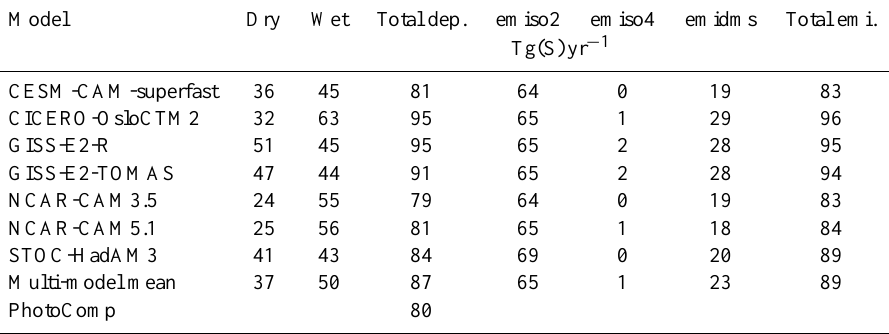
Table 4. Summary of global totals (Tg(S)yr − 1 ) for year 2000 of deposition and emissions related to the sulfur emissions. “Total dep.” (4th column) is the sum of wet and dry deposition (both sums of SO 2 and SO 2 − ), while “Total emi.” (8th column) is the sum of SO 2 , SO 2 − and 4 4 DMS emissions. Note that the deposition total should be smaller than the emission total since the formation of sulfate from the oxidation of DMS has a yield smaller than 1; this was estimated to be 87% in Boucher et al. (2003) when both gas-phase and aqueous-phase reactions are taken into account. All numbers are rounded to the nearest integer. Model Dry Wet Total dep. emiso2 emiso4 emidms Total emi. Tg(S)yr −